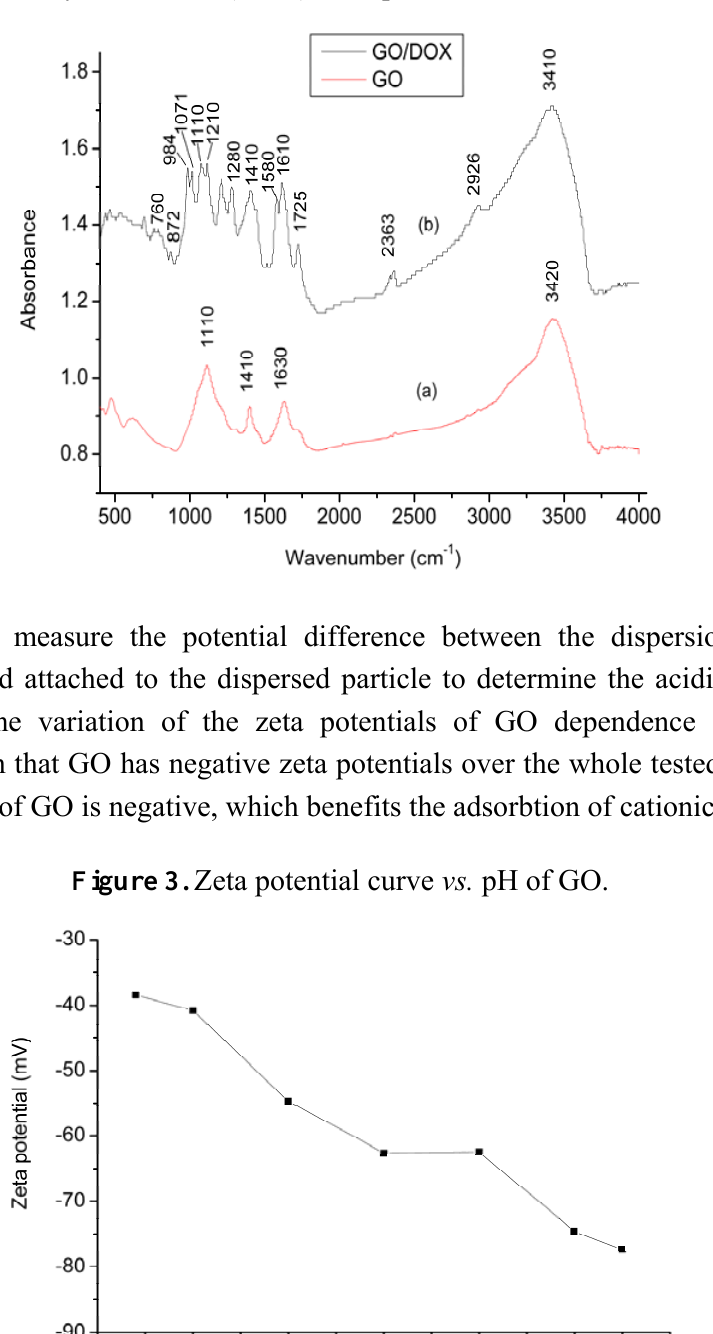
Figure 2. Fourier transform infrared spectroscopy (FTIR) spectra of GO: ( a ) before and ( b ) after doxorubicin hydrochloride (DOX) adsorption.